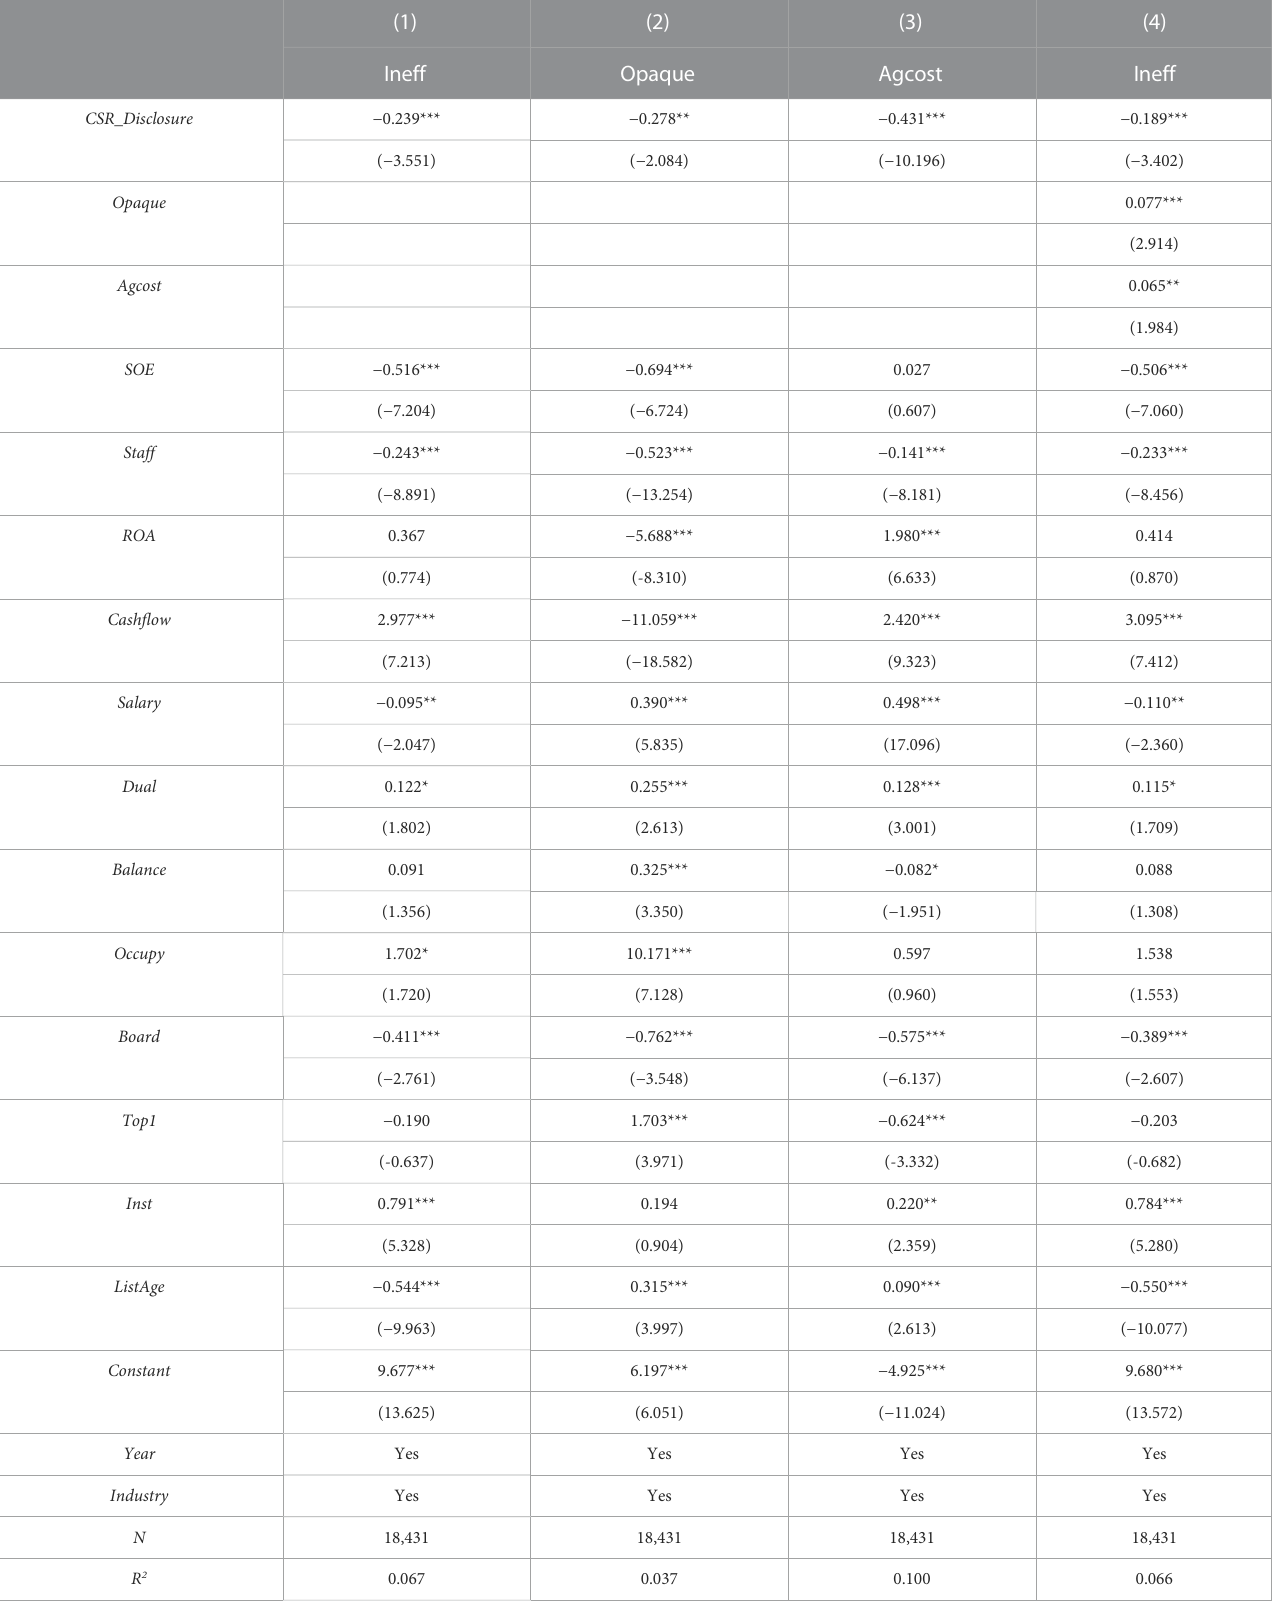
TABLE 5 Regression results from the mediating effect of information asymmetry and agency